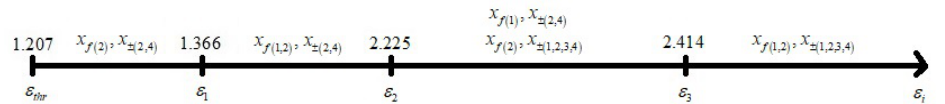
Figure 3. The regions of the initial electron energy values (in units of X-ray-stimulated Breit–Wheeler process threshold energy ω thr ) and the possible energies of the scattered electron and the pair particles in these regions (see Conditions